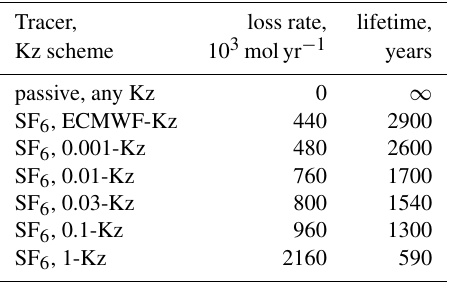
Table 1. SF 6 destruction rate after stopping the emissions and cor- responding lifetimes. Mid-2011 burden of 1 . 27 × 10 9 moles is used as a reference for the lifetime